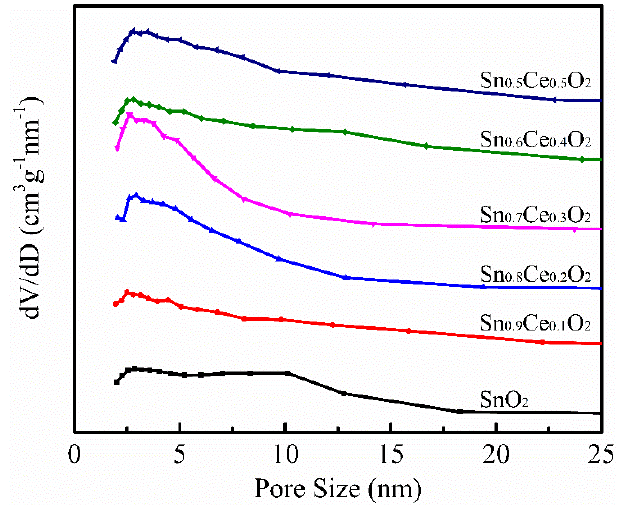
Figure 6. Pore size distribution of the SnO 2 and Sn x Ce 1-x O 2 fiber catalysts. The H 2 -TPR profiles of the SnO 2 and Sn x Ce 1-x O 2 fiber catalysts are shown in Figure 7. The curve of the SnO 2 fiber presented a reduction peak in the range of 400–600 °C, which was the reduction in bulk Sn 4+ to Sn 2+ and the reduction in surface Sn 2+ to Sn 0 [8,34,35]. Compared with the SnO 2 fiber, all the reduction peaks of Sn x Ce 1-x O 2 fibers moved in a lower temperature direction. The redox balance Sn 4+ + 2Ce 3+ ↔ Sn 2+ + 2Ce 4+ occurred in